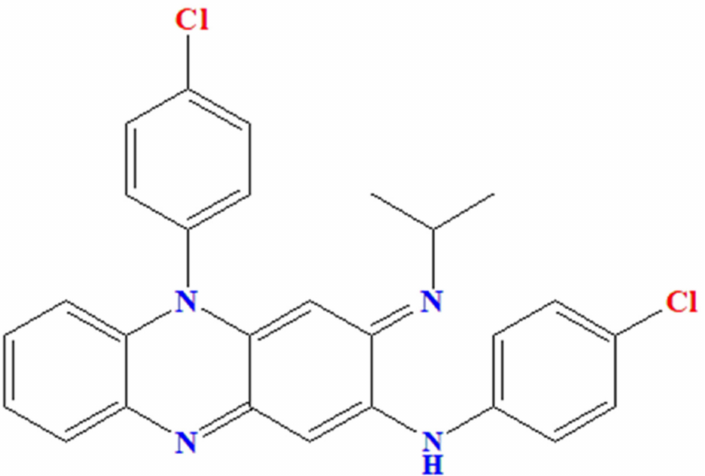
Figure 1. Molecular structure of clofazimine. (The figure was modified from PubChem)